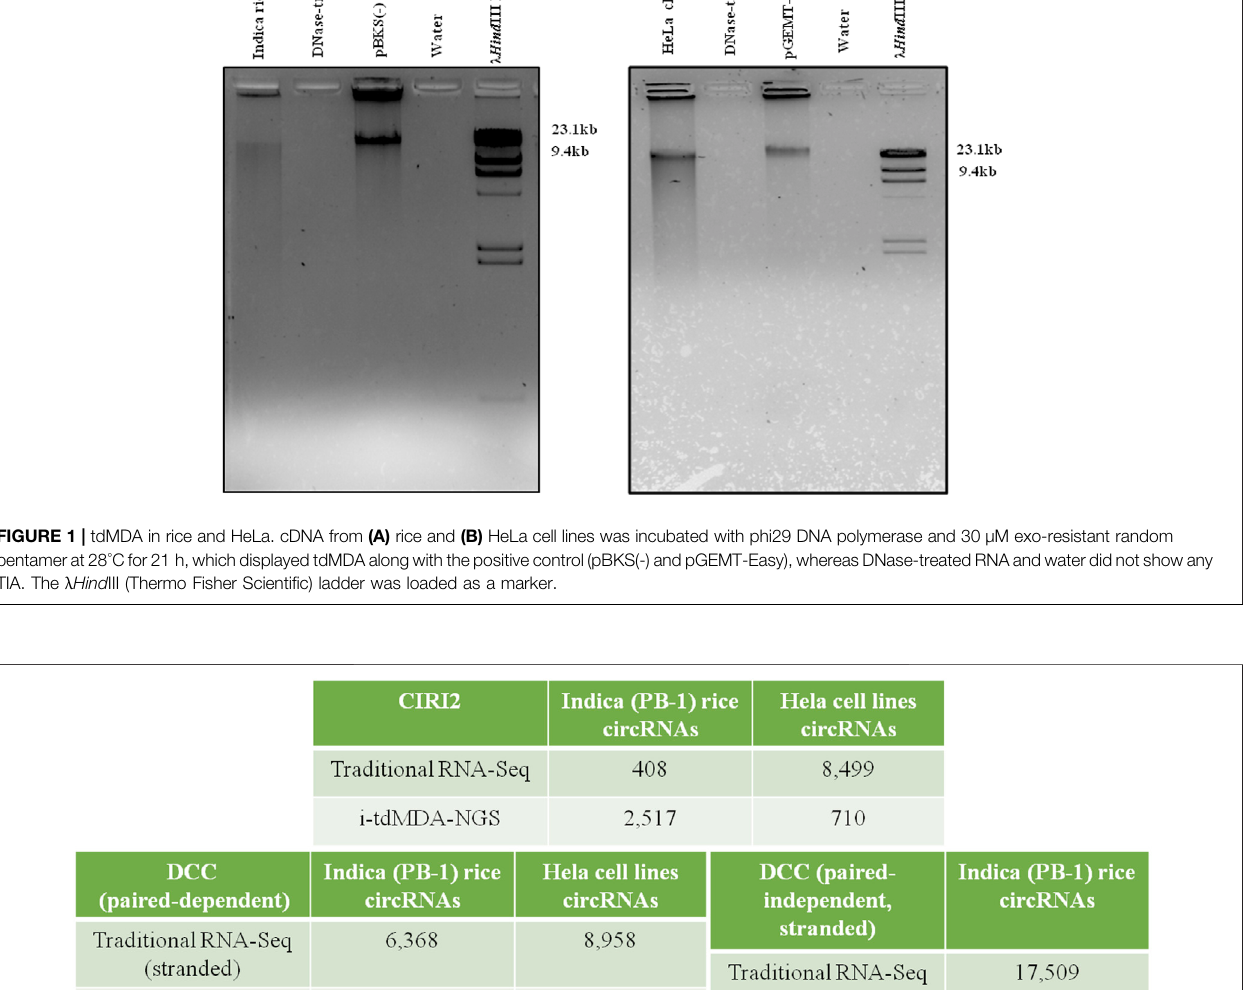
respectively ( Supplementary Figure S6B ). ~55% (#225) and ~39% (#161) of circRNAs identi fi ed by traditional RNA-Seq were in the < 1000 nt and 1000 – 9999 nt size range, respectively ( Supplementary Figure S6C ), whereas i-tdMDA-NGS contributes ~45% (#1,143) and ~51% (#1,299) of circRNAs in the same categories ( Supplementary Figure S6C ). In traditional RNA-Seq, 255 and 11 genes were giving single and two circRNAs, respectively, and 32% (#131) circRNAs were coming from genes without any annotation ( Supplementary Figure S6E ). On the contrary, there were 1,015 and 188 genes yielding one and two circRNAs, respectively, in i-tdMDA-NGS apart from ~30%